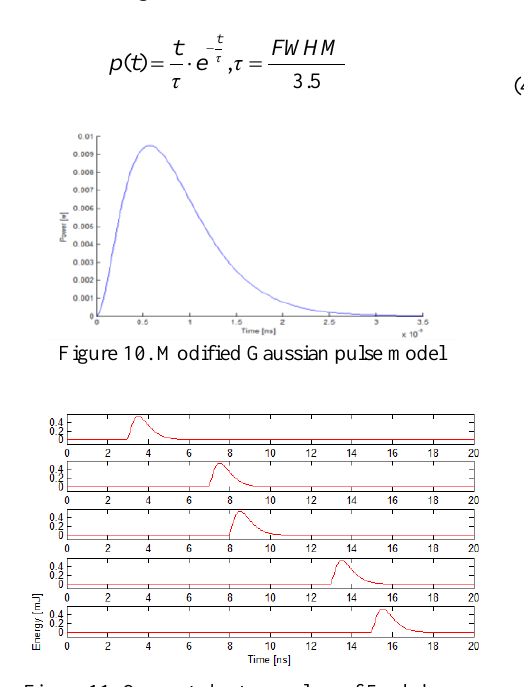
Figure 11. Generated return pulses of 5 sub-beams